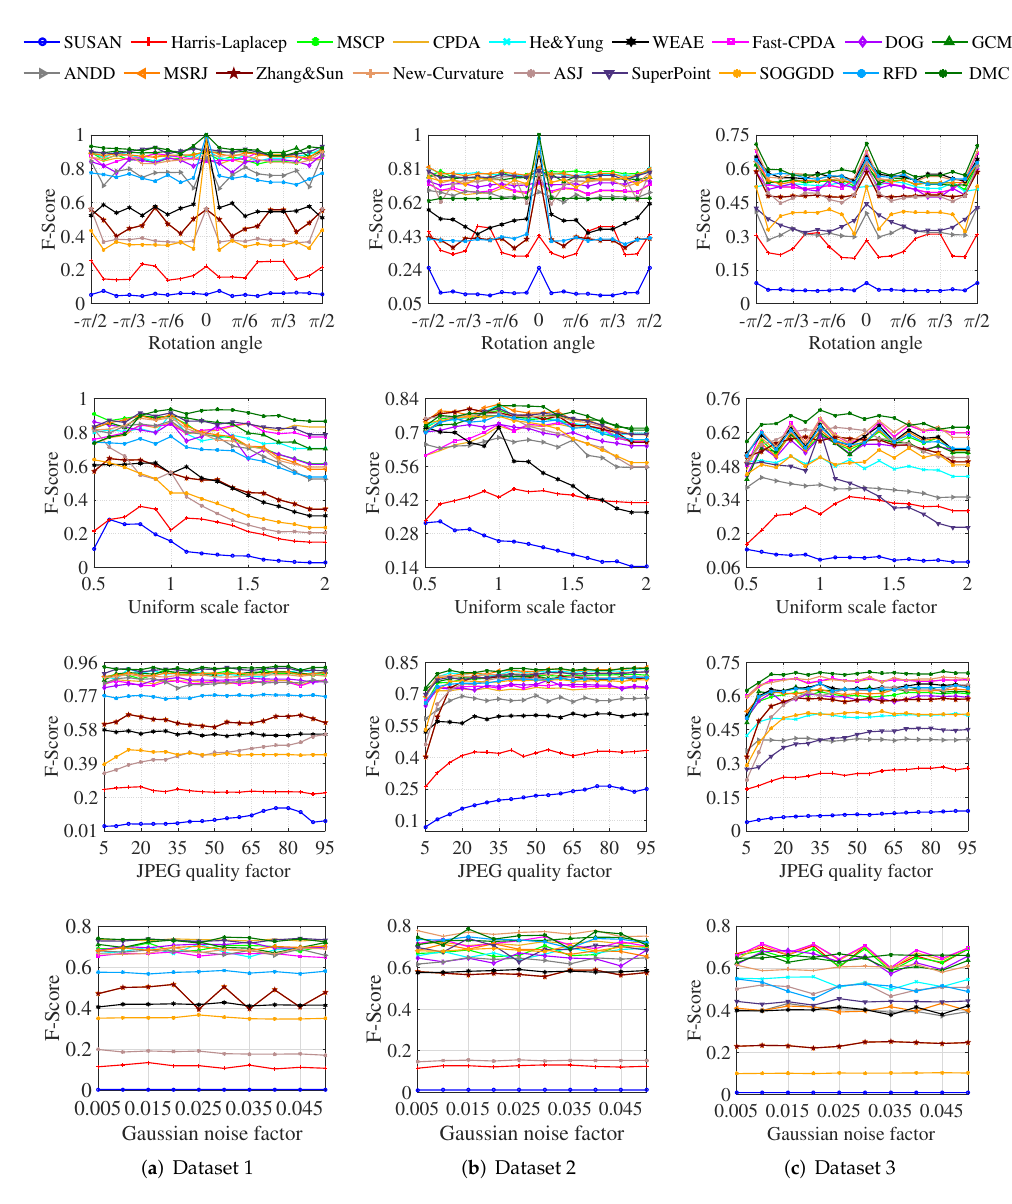
Figure 4. Evaluation results with degraded images.